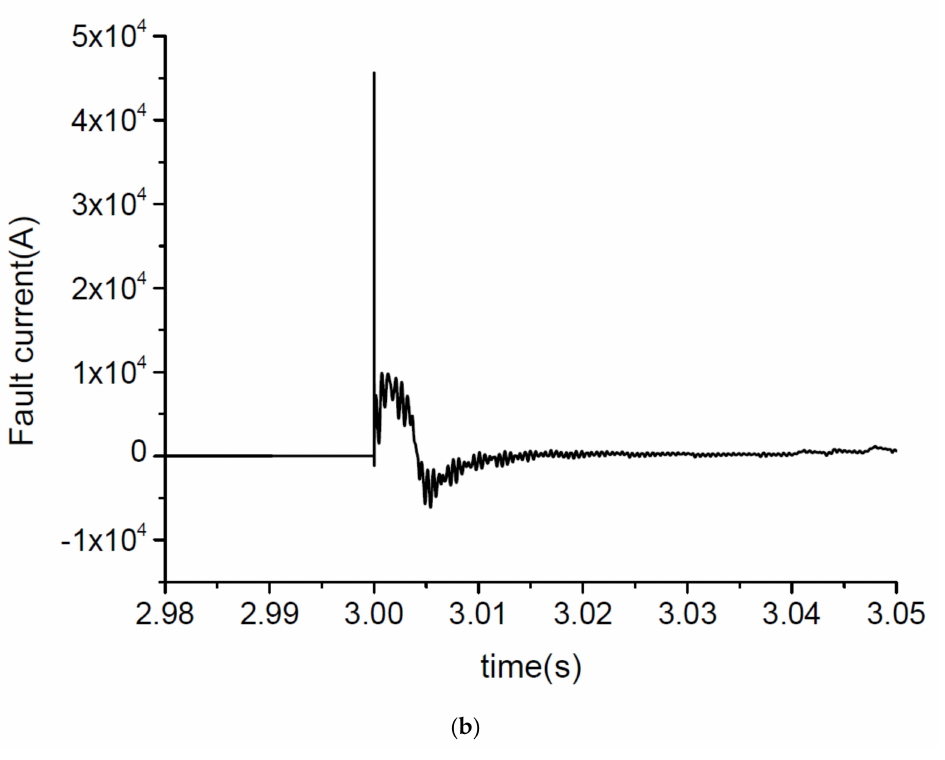
Figure 4. DCCB simulation condition proposed in this paper (VSC-Based HVDC transmission line) ( a ) Schematic diagram the DCCB simulation; ( b ) Magnitude of the fault current (Fault current occurrence time = 3.00 s). Table 1. Transmission line parameters used to simulate the proposed DCCB.